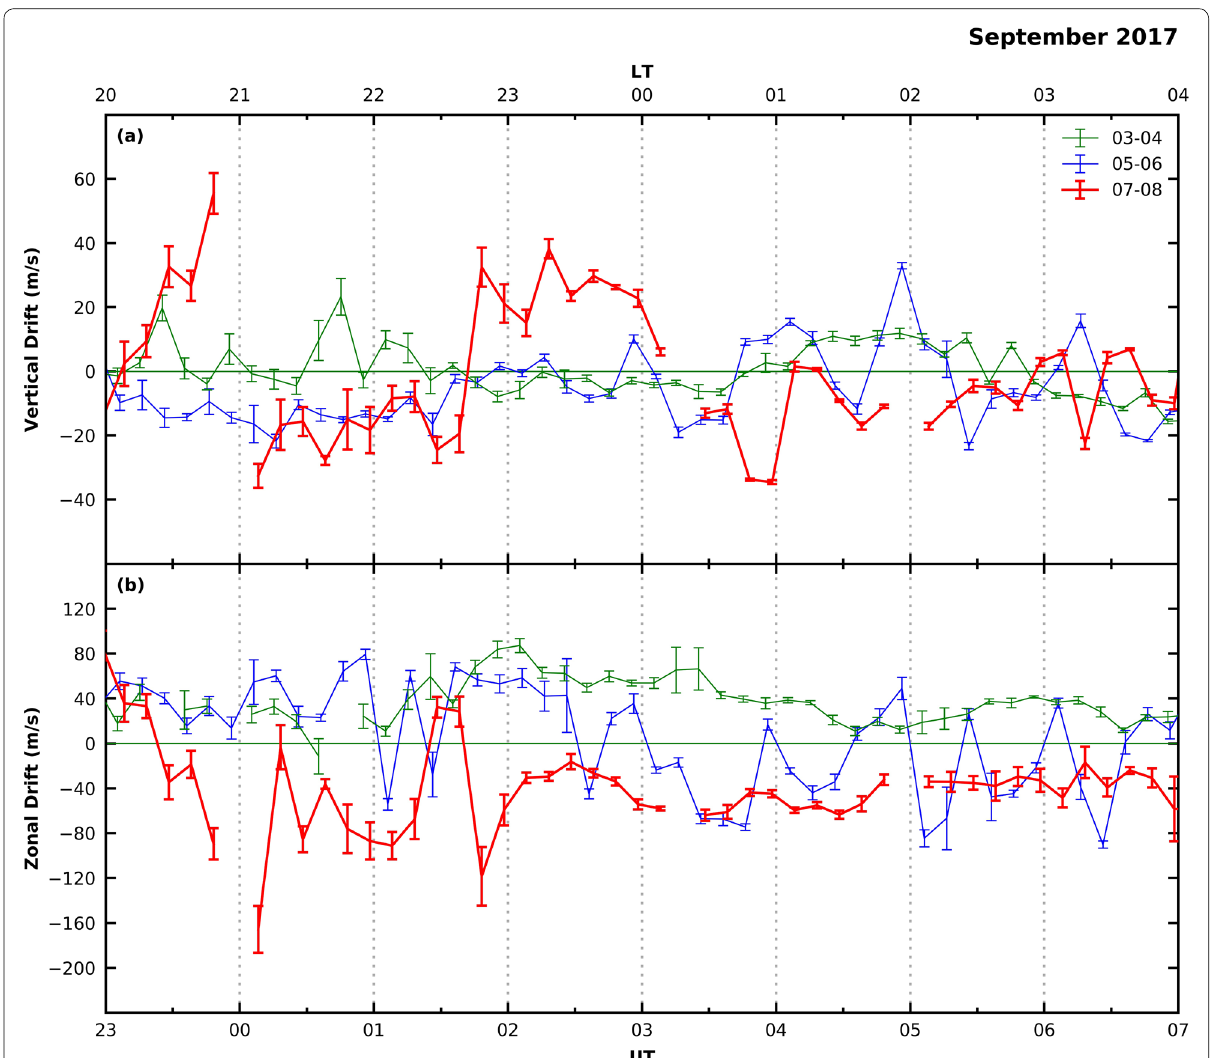
Fig. 4 Vertical ( a ) and zonal ( b ) plasma drift components over São Luís inferred by Digisonde data for the nights 03/04, 05/06 and 07/08, which are positive upwards and eastwards, respectively. The measurement error bars are represented for each 10